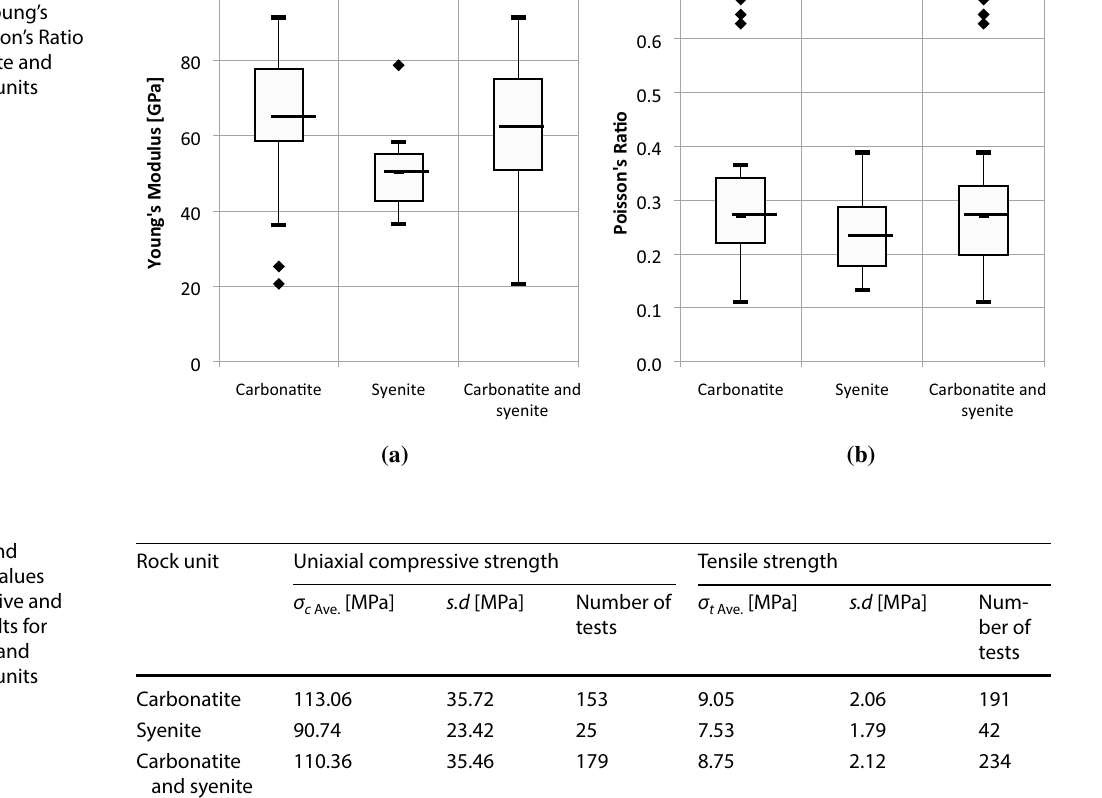
Fig. 5 Box-plot diagrams for the results of a Young’s Modulus and b Poisson’s Ratio of syenite, carbonatite and carbonatite-syenite units